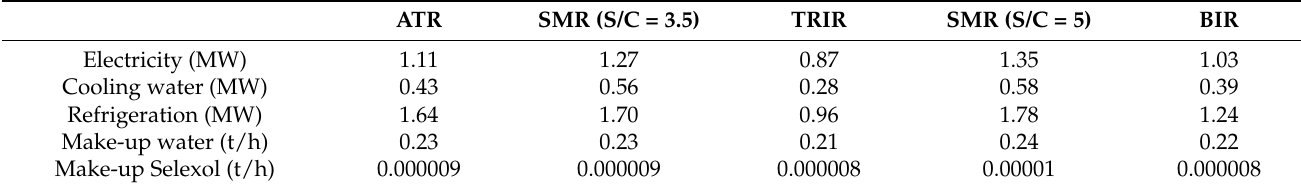
Table 13. Utilities and raw materials demand for Selexol process with different feed processes. ATR SMR (S/C = 3.5)